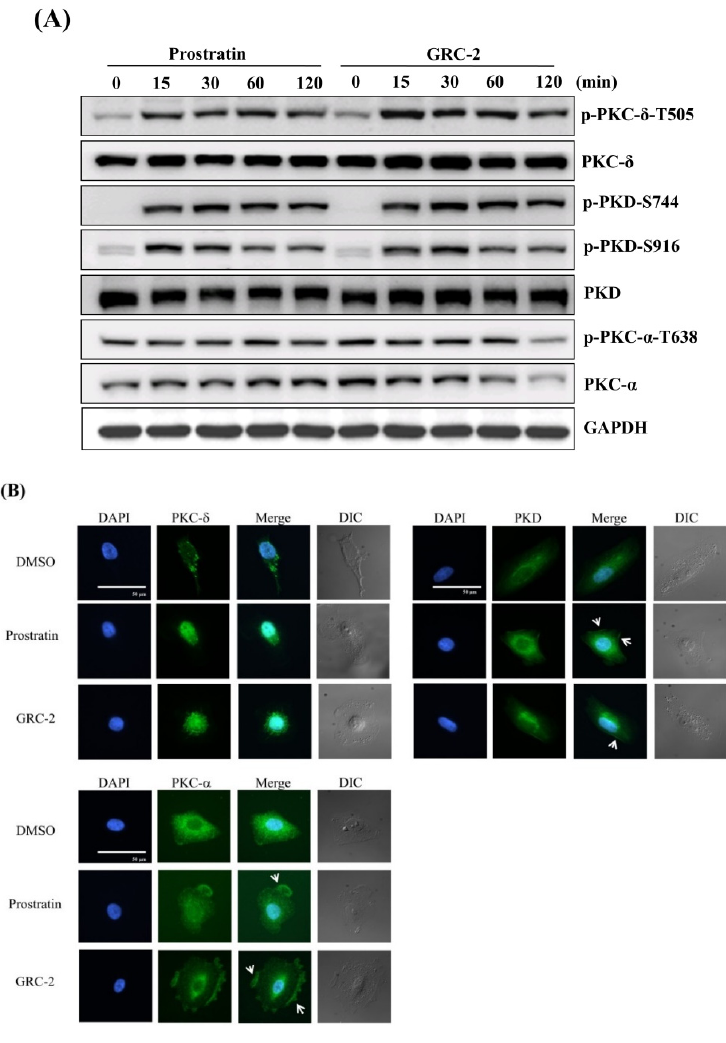
Figure 3. Prostratin and GRC-2 activates PKC isoforms and PKD in A549 cells. ( A ) A549 cells were treated with prostratin (3 µ M) or GRC-2 (300 nM) for indicated periods. Cells were harvested and subjected to immunoblotting for PKC- δ , PKD, and PKC- α . ( B ) A549 cells were treated with prostratin (3 µ M) and GRC-2 (300 nM) for 10 min. PKC- δ , PKD, and PKC- α translocation (green) were detected by immunofluorescence. Nuclei were counterstained with 4 (cid:48) ,6-diamidino-2-phenylindole (DAPI) (blue). The images were overlapped (Merge) to determine translocation. The cell morphology was visualized with di ff erential interference contrast (DIC) optics. Scale bar, 50 µ m. White arrows indicate PKCs or PKD which were translocated to the cell